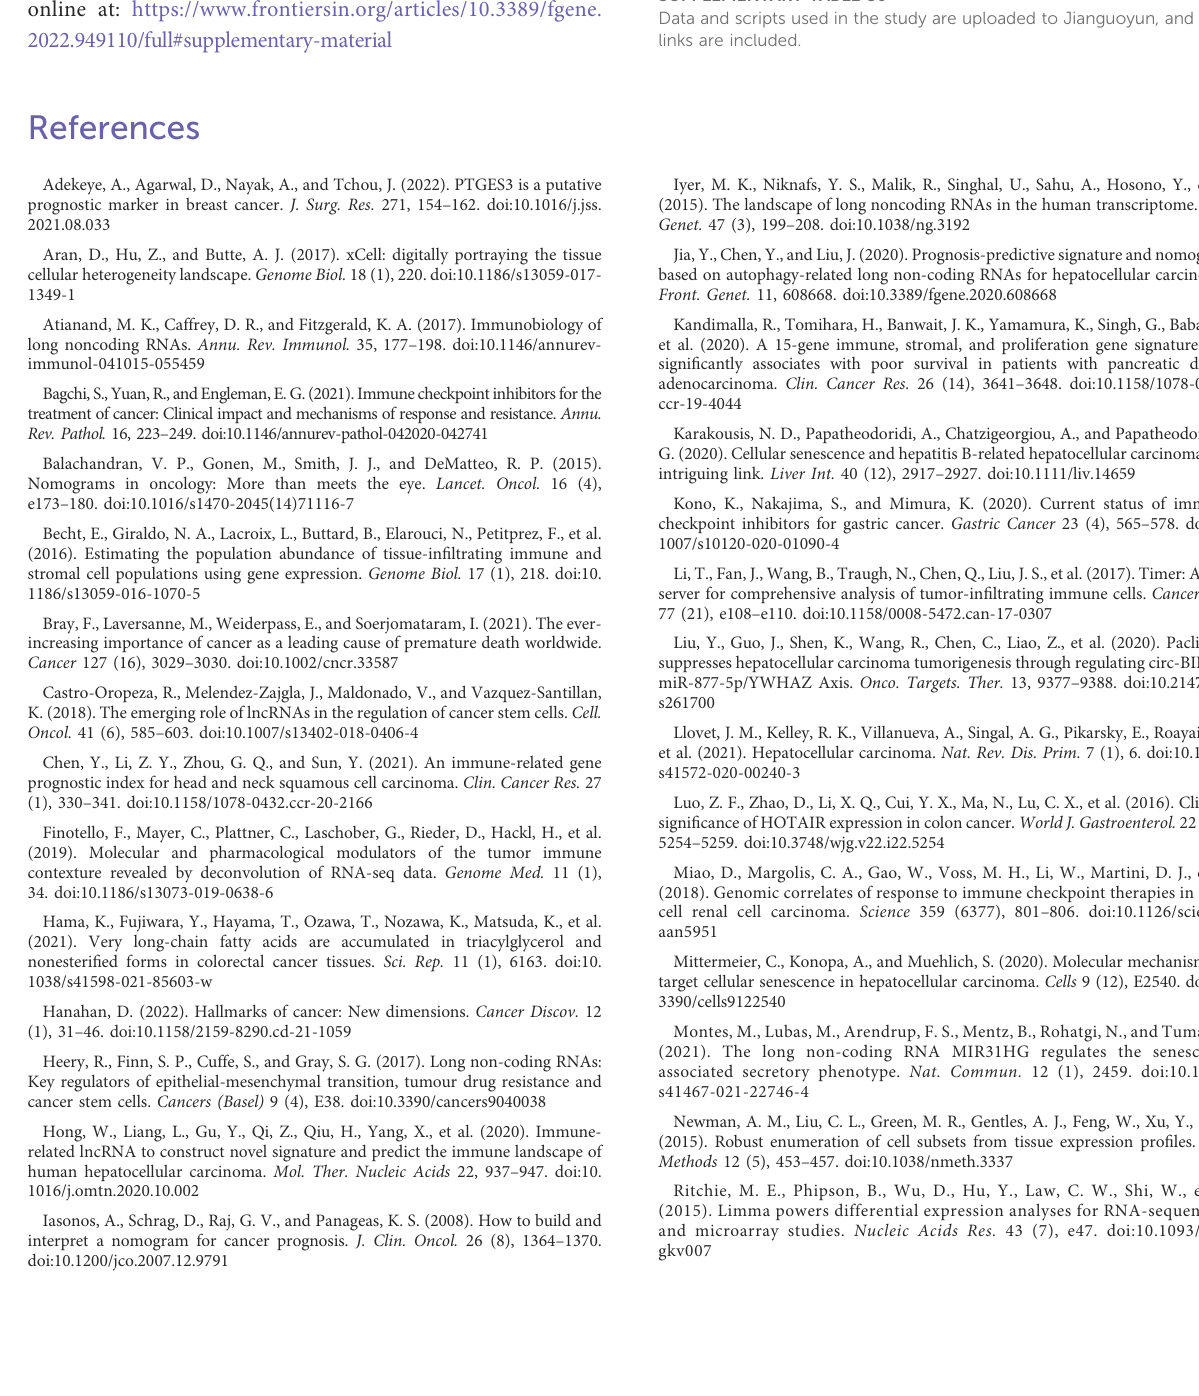
SUPPLEMENTARY TABLE S2 422 senescence-related lncRNAs. SUPPLEMENTARY TABLE S3 33 lncRNAs extracted by univariate Cox regression analysis. SUPPLEMENTARY TABLE S4 3 lncRNAs used to construct prognostic model. SUPPLEMENTARY TABLE S5 Raw data of